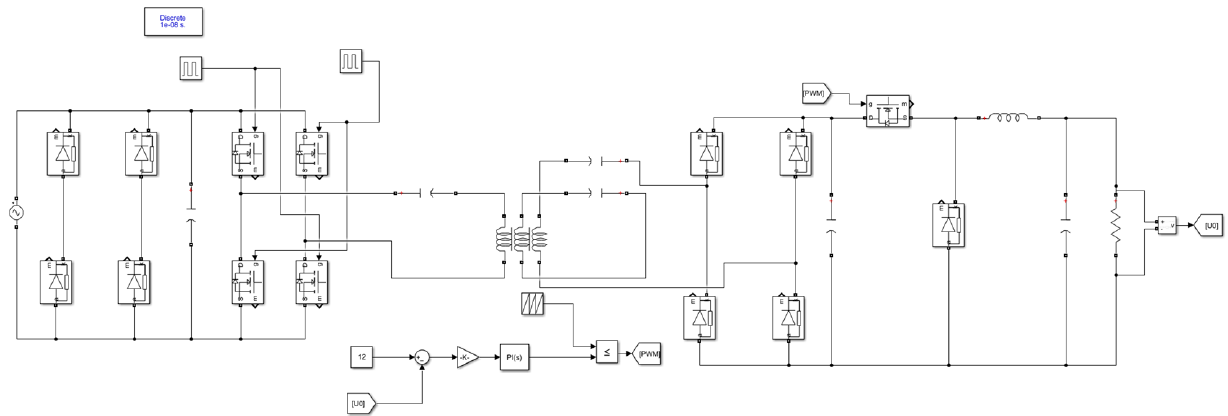
Figure 14. System simulation circuit.